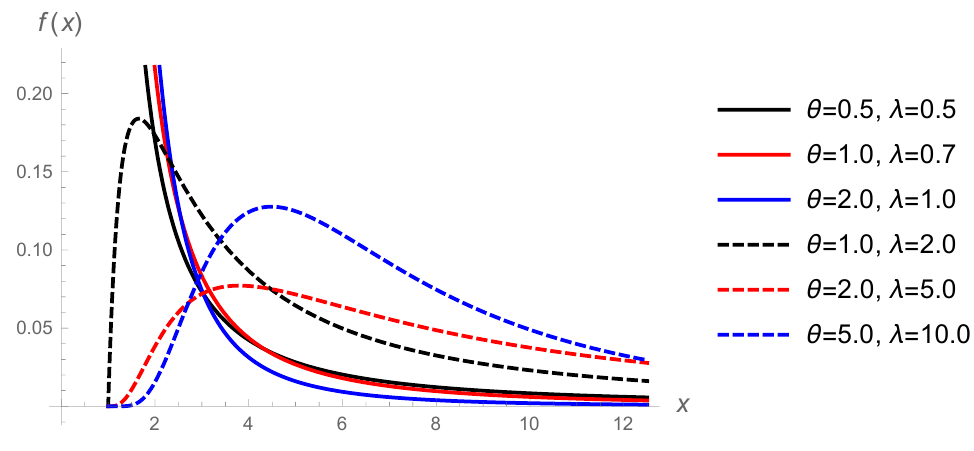
Figure 1. Probability density function of GTLG distribution for selected values of θ and λ when α =